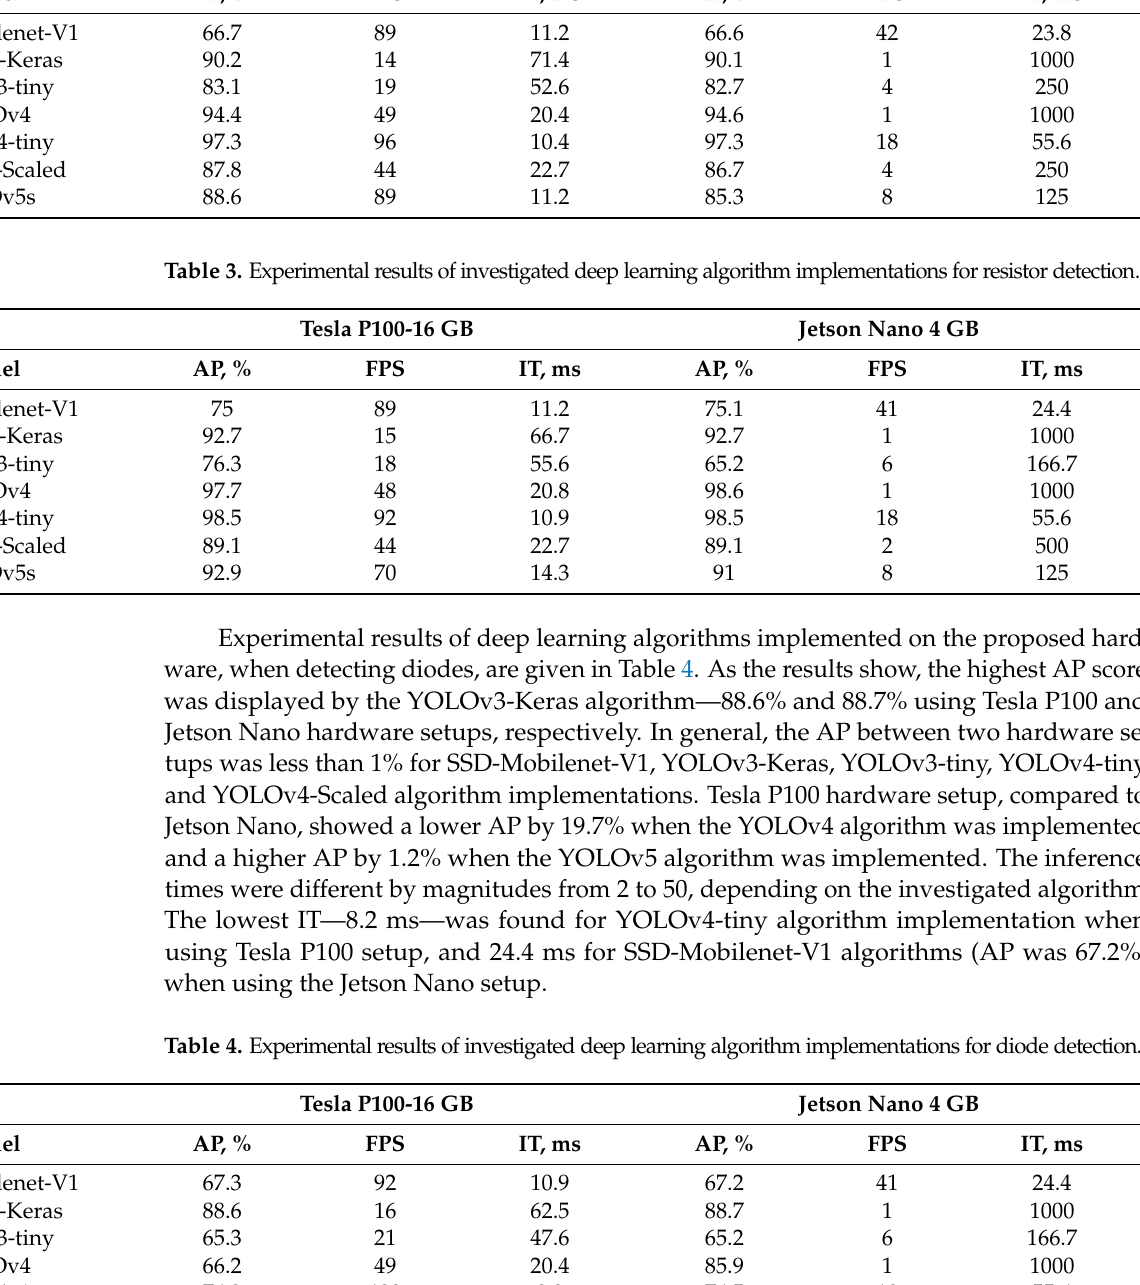
Table 2. Experimental results of investigated deep learning algorithm implementations for capacitor detection. Tesla P100-16 GB